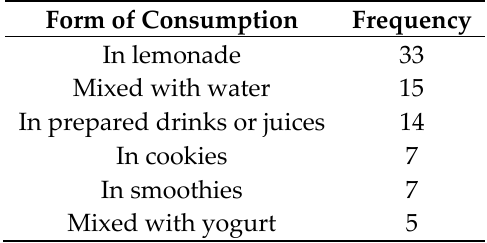
Table 2. Form of consumption and benefits mentioned by consumers of S. hispanica L. in Guatemala.